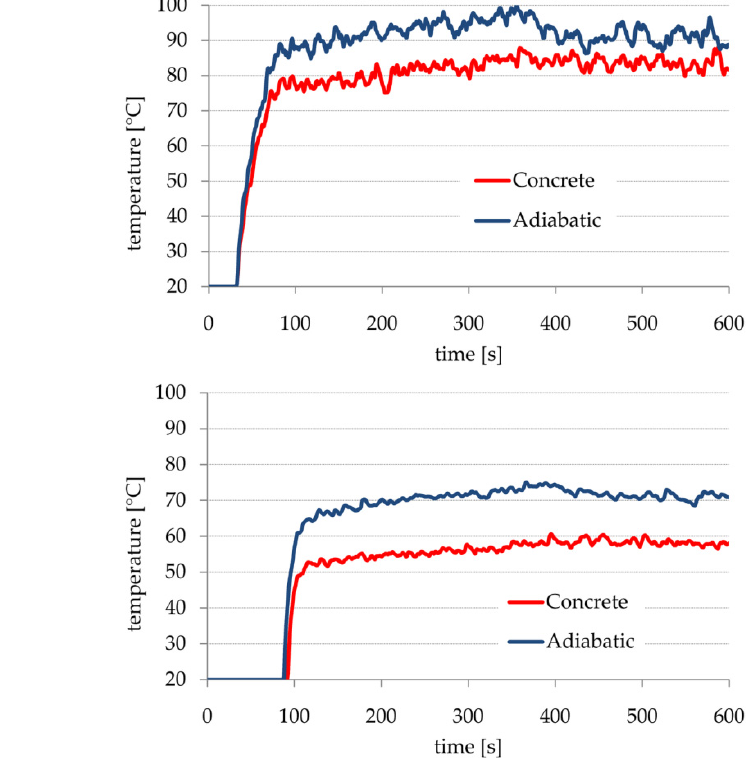
Figure 1. Temperatures recorded at: ( a ) 25 m, ( b ) 100 m downstream the fire.